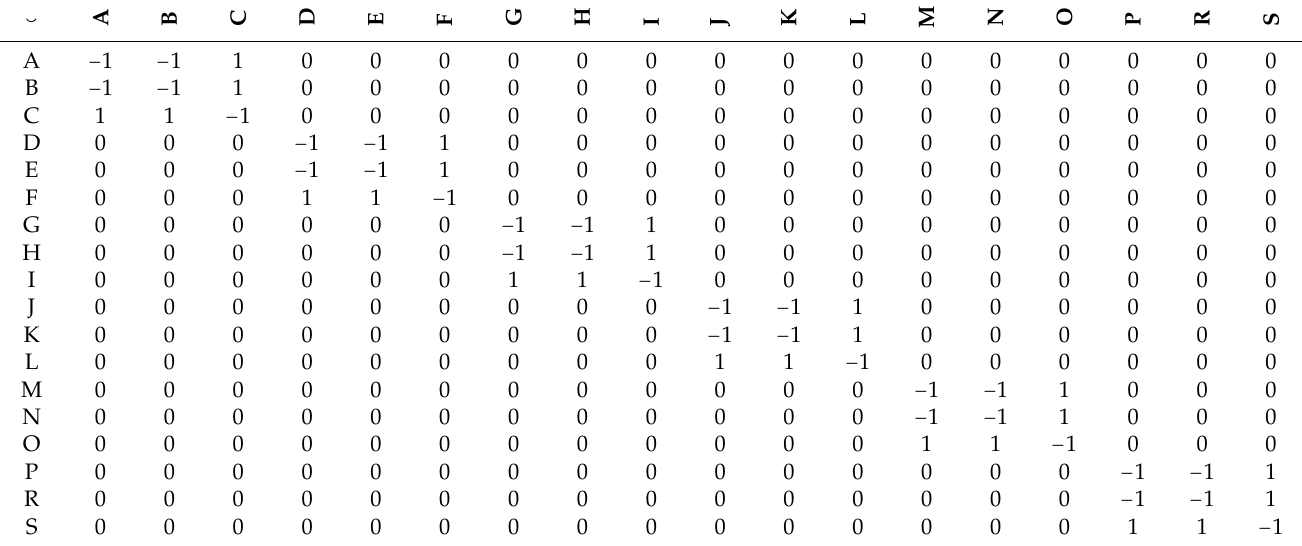
Table A2. Cup product of the cocycles deduced from Figure A8.